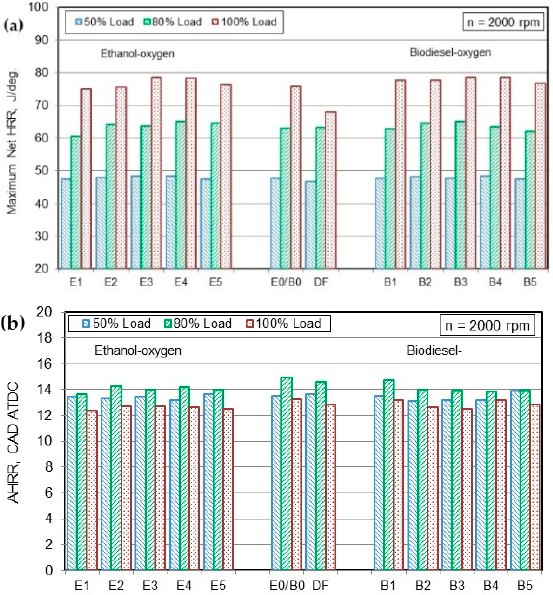
Figure 5. Maximum heat release rate ( a ) and its location angle ATDC ( b ) as a function of ethanol– oxygen or biodiesel-oxygen mass content (wt%) in fuel blends when running under medium (50%), intermediate (80%), and full (100%) loads corresponding to the respective IMEP = 0.75, 1.20, and 1.50 MPa developed at maximum torque speed of 2000